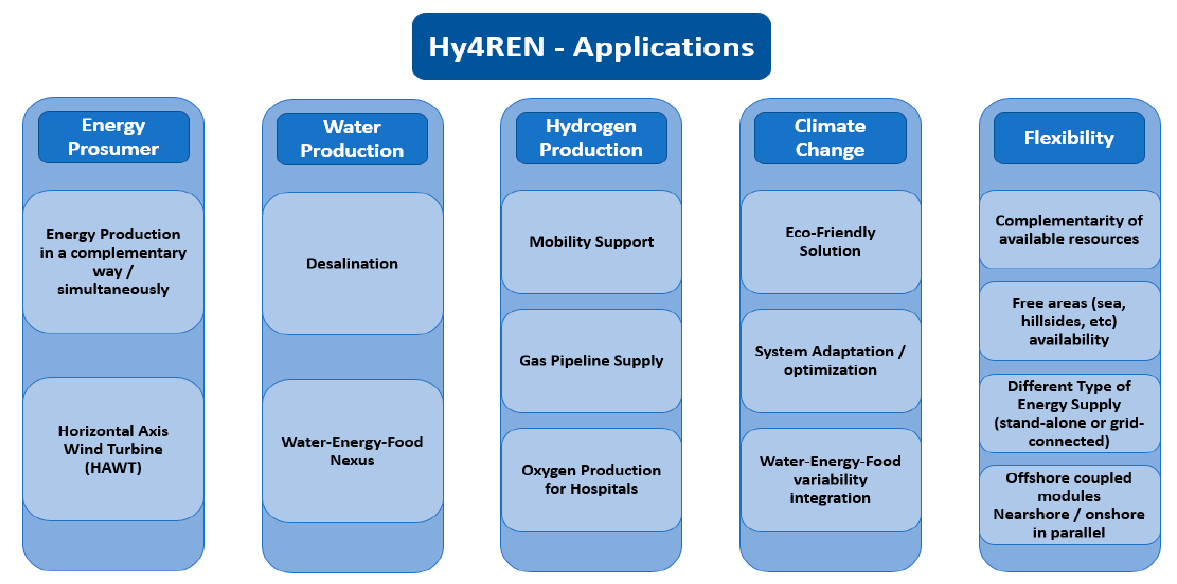
Figure 22. New integrated renewable energy concept—Hybrid for Renewable Energy Network (Hy4REN)—needs ( top ) and applications ( bottom ).